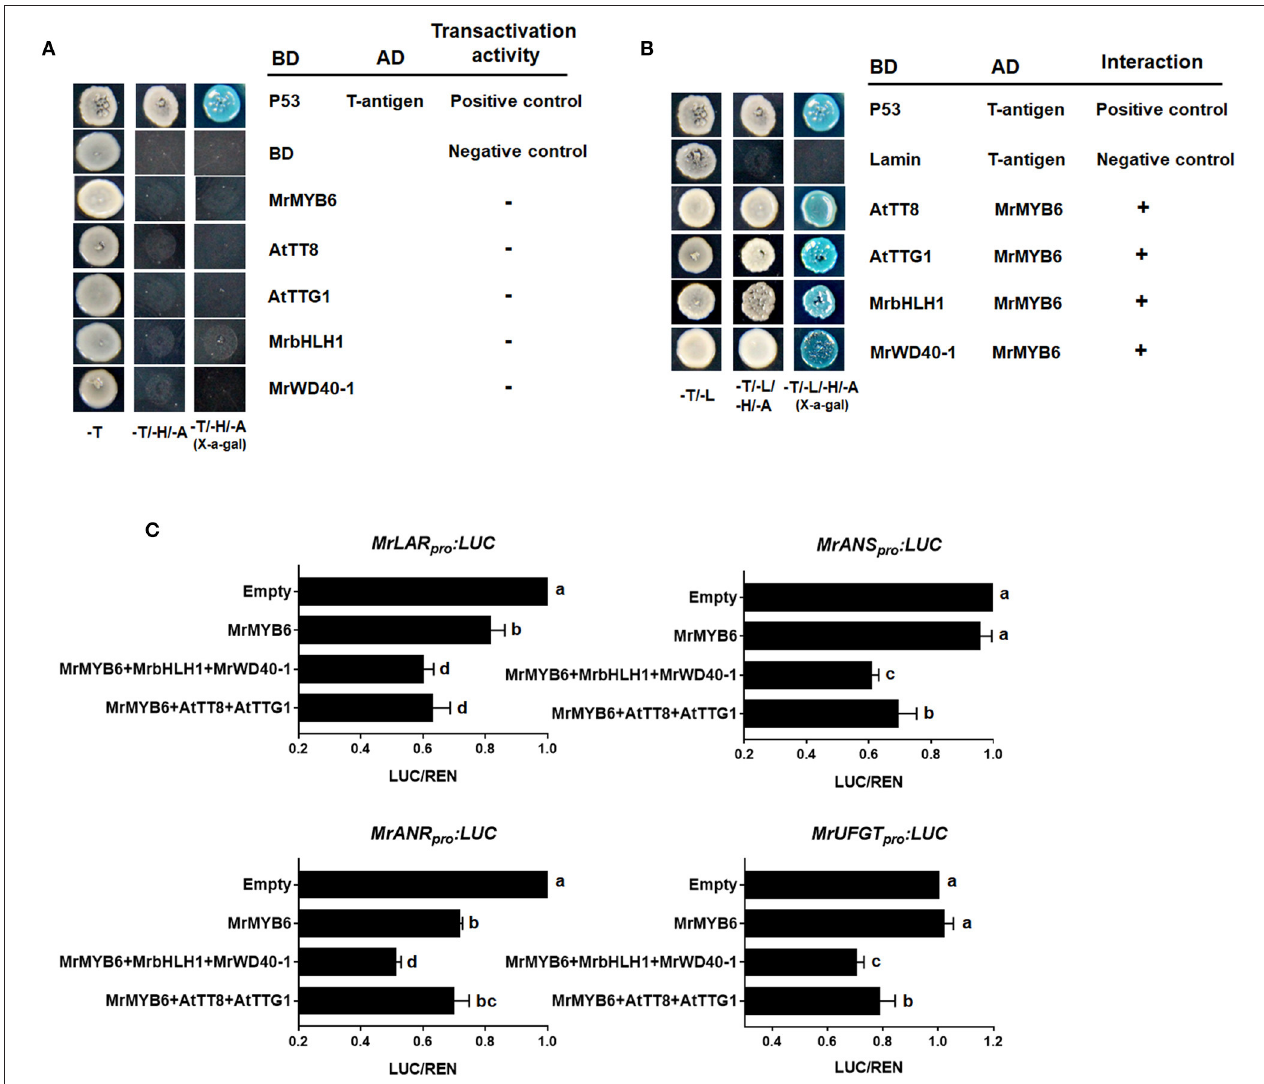
FIGURE 3 | The role of MrMYB1-MrbHLH1-MrWD40-1 complex. (A) Autoactivation tests in yeast cells. (B) MrMYB6 interacts with AtTT8/AtTTG1/MrbHLH1/MrWD40-1 in yeast. -T, SD/-Trp medium; -T/-H/-A, SD/-Trp-His-Ade medium; -T/-L, SD/-Trp-Leu medium; -T/-L/-H/-A, SD/-Trp-Leu-His-Ade medium; BD, DNA-binding domain; AD, activation domain. (C) Transcriptional repression ability of MrMYB6 to the promoters of PA-specific gene MrLAR and MrANR and anthocyanin-specific gene MrANS and MrUFGT. The LUC/REN ratio of the empty vector plus promoter was set as 1. Different letters above the columns indicate significant differences at p < 0.05. Error bars indicate SE from four biological